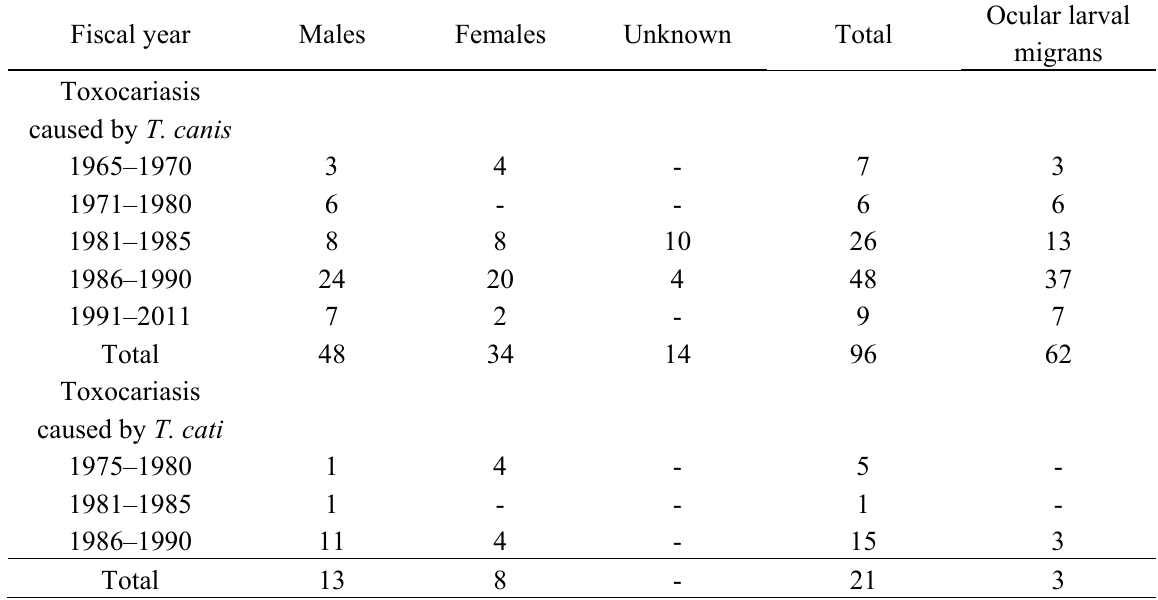
Ocular larval migrans